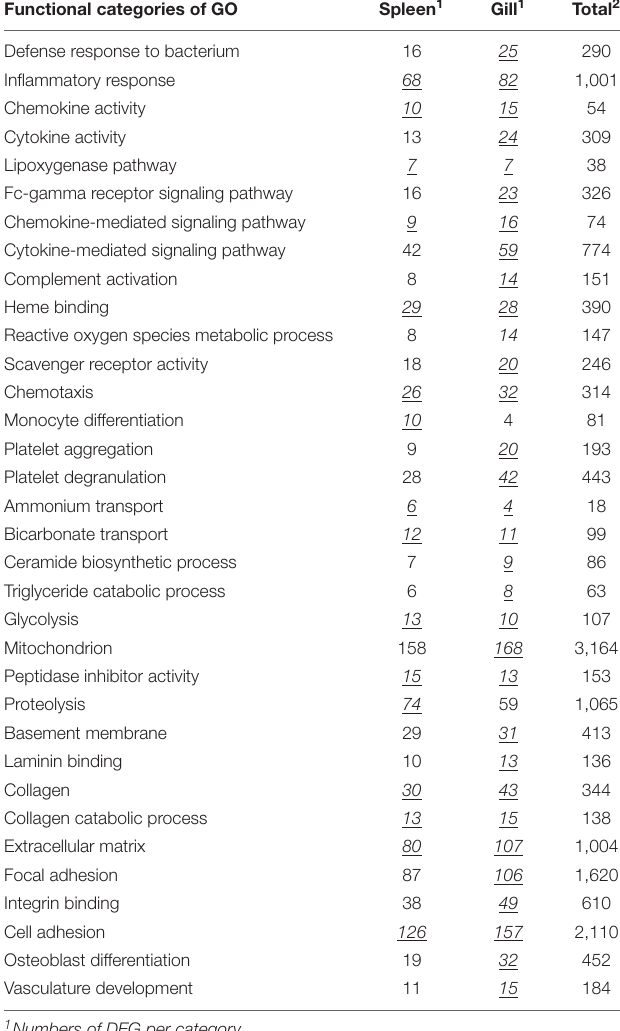
TABLE 2 | Enrichment of functional categories of GO in the list of genes that responded to challenge with M. viscosa . Functional categories of